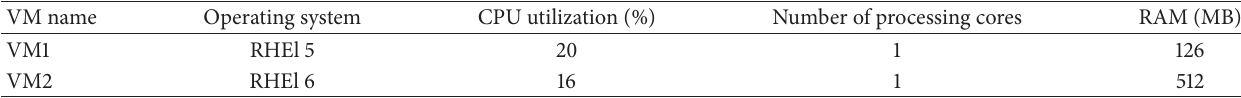
Table 23: Local list of node 4